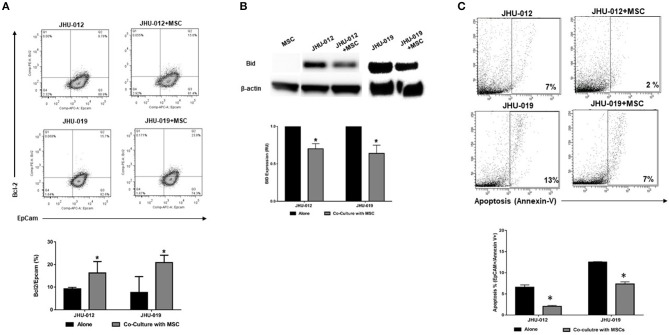
MSCs mediate increased expression of Bcl-2, decreased expression of Bid, and decreased apoptosis in OSCC. JHU-012, and −019 were grown in a 1:1 co-culture with MSCs for 6 days. Bcl-2, Bid and apoptosis expression measured. EpCAM was used to identify cells of epithelial lineage and CD90 used to identify mesenchymal cells. (A) There was a significant increase in the expression of bcl-2/EpCAM+ cells in co-cultures derived from JHU-012 and −019 compared to cancer cells grown alone (n = 3; p < 0.04). (B) There was a significant reduction in bid expression across in JHU-012 and −019 co-cultured with MSCs compared to cancer cells grown alone (n = 3; p < 0.001). (C) There was a significant reduction in the number EpCAM+/annexin V+ cancer cells undergoing apoptosis in the co-cultures derived from JHU-012 and JHU-019 compared to cancer cells grown alone (*p < 0.001, n ≥ 3).